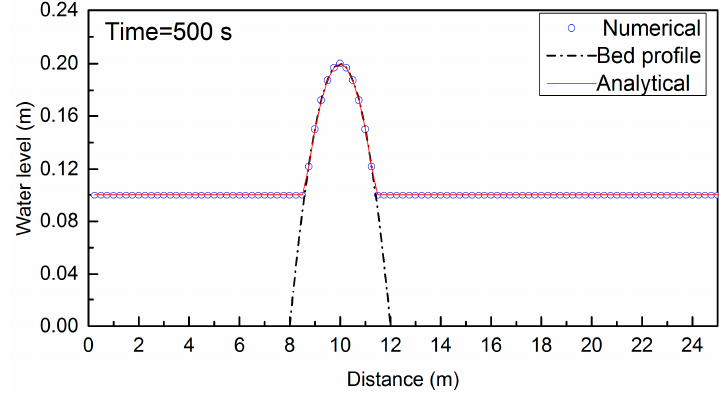
Figure 5. Still-water test after 500 s.